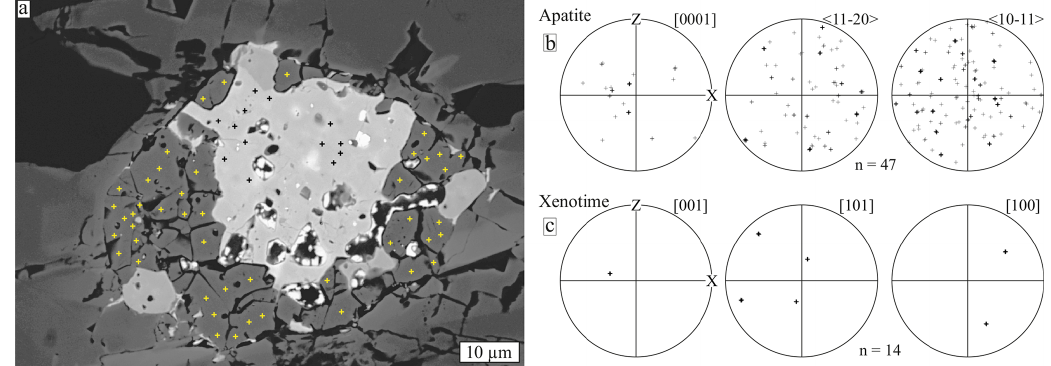
Figure 13. EBSD point measurements on fluorapatite and xenotime. (a) The measurement locations: yellow for fluorapatite and black for xenotime. (b, c) The pole figures (equal angle projection of the lower hemisphere) for fluorapatite (b) and xenotime (c) .